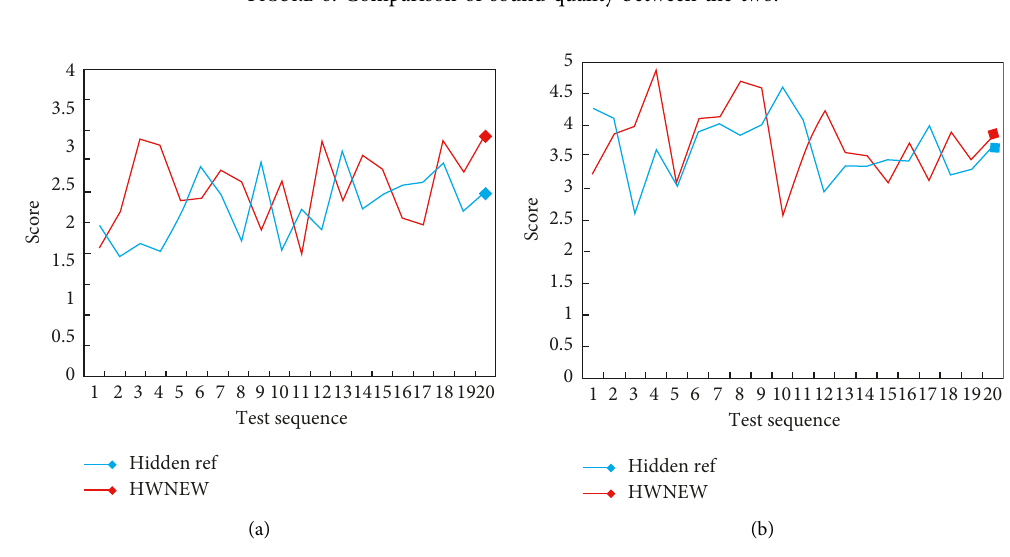
Figure 6: Comparison of sound quality between the two.